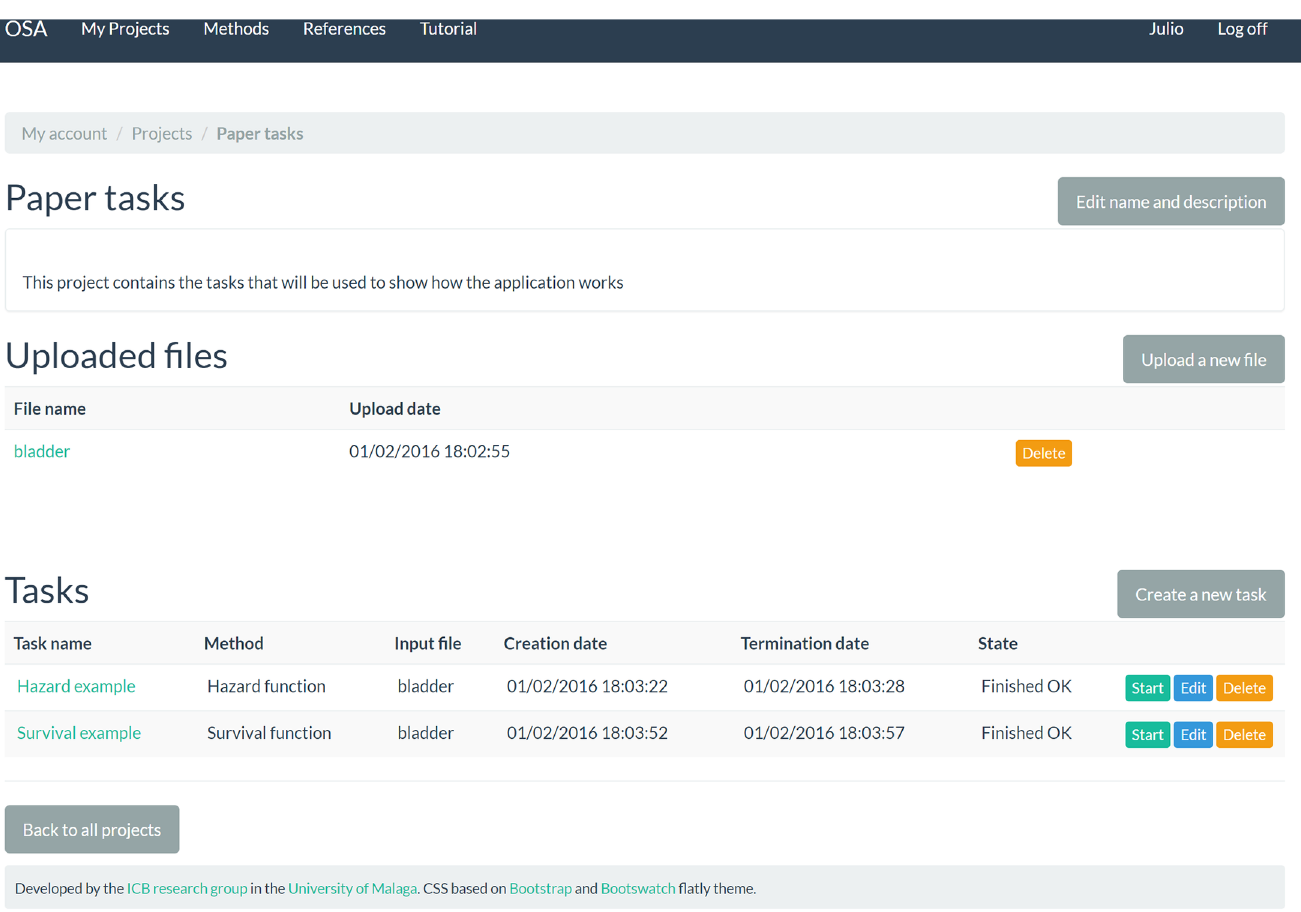
Fig 2. Screenshot of a project page. Here, the user can upload datasets and create tasks.